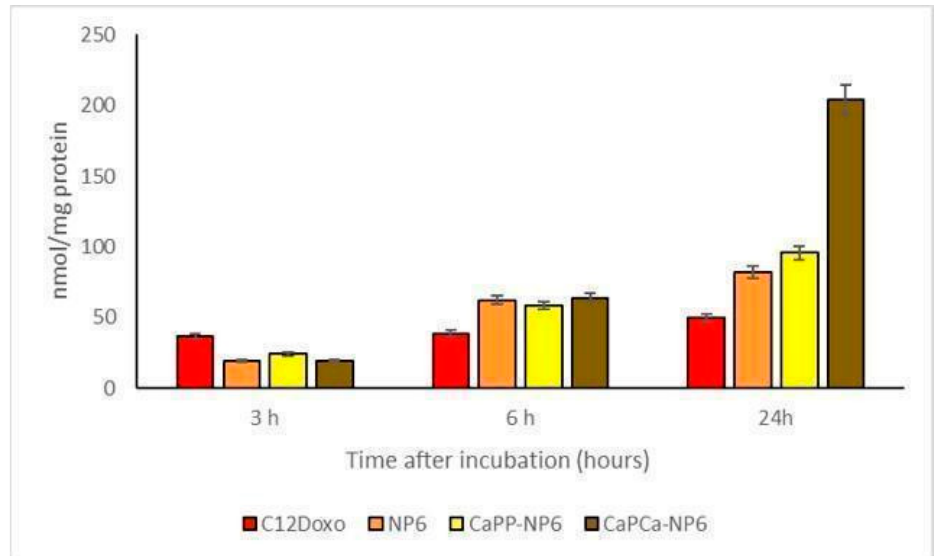
Figure 8. D17 cells were incubated with 5 µg/mL C12DOXO or with NP6, CaP P -NP6, and CaP Ca -NP6, carrying 5 µg/mL C12DOXO, for 1, 3, 6, and 24 h. Intracellular retention of DOXO was measured spectrofluorimetrically. Results are means ± SD ( n = 3).